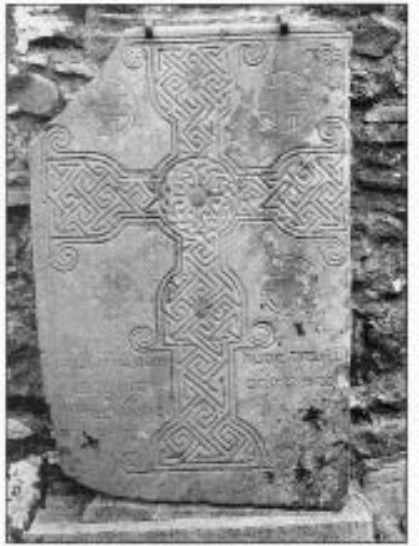
Figure 2 Irish grave-slab of eighth-or ninth-century AD date from Tullylease, Co. Cork, calling for prayers fora man with an Anglo-Saxon name,